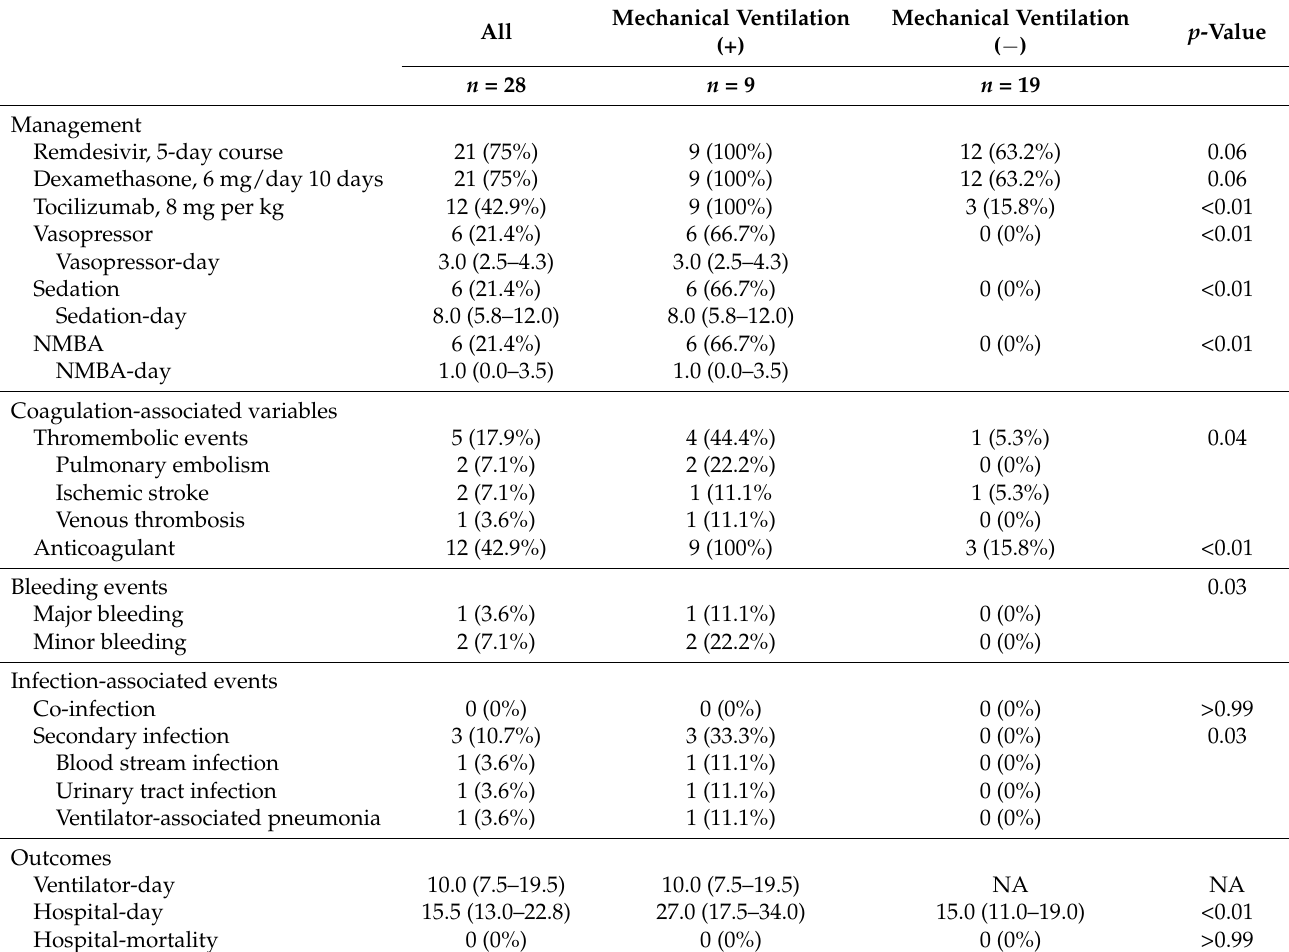
Table 2. Management and outcome of enrolled patients with COVID infection categorized by the need for mechanical ventilation.